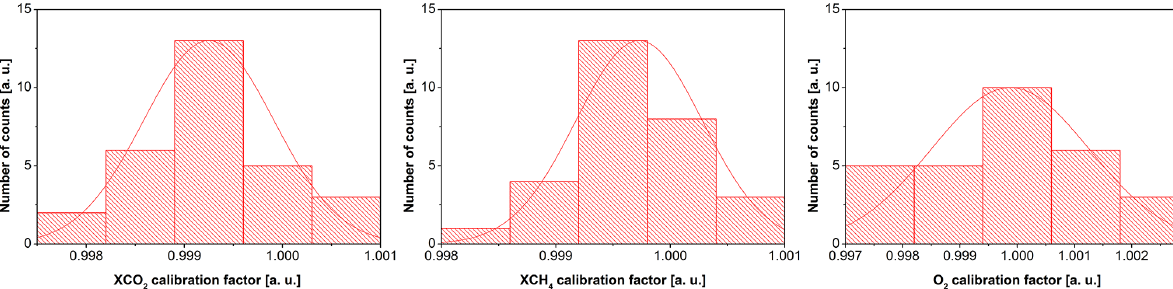
Figure 11. Histograms of the empirical XCO 2 , XCH 4 , and O 2 calibration factors for the different instruments with respect to the refer- ence EM27/SUN. The red line overlying the histograms is a fit of a Gaussian function to the histogram. For the histograms, calibration measurements of 29 instruments were